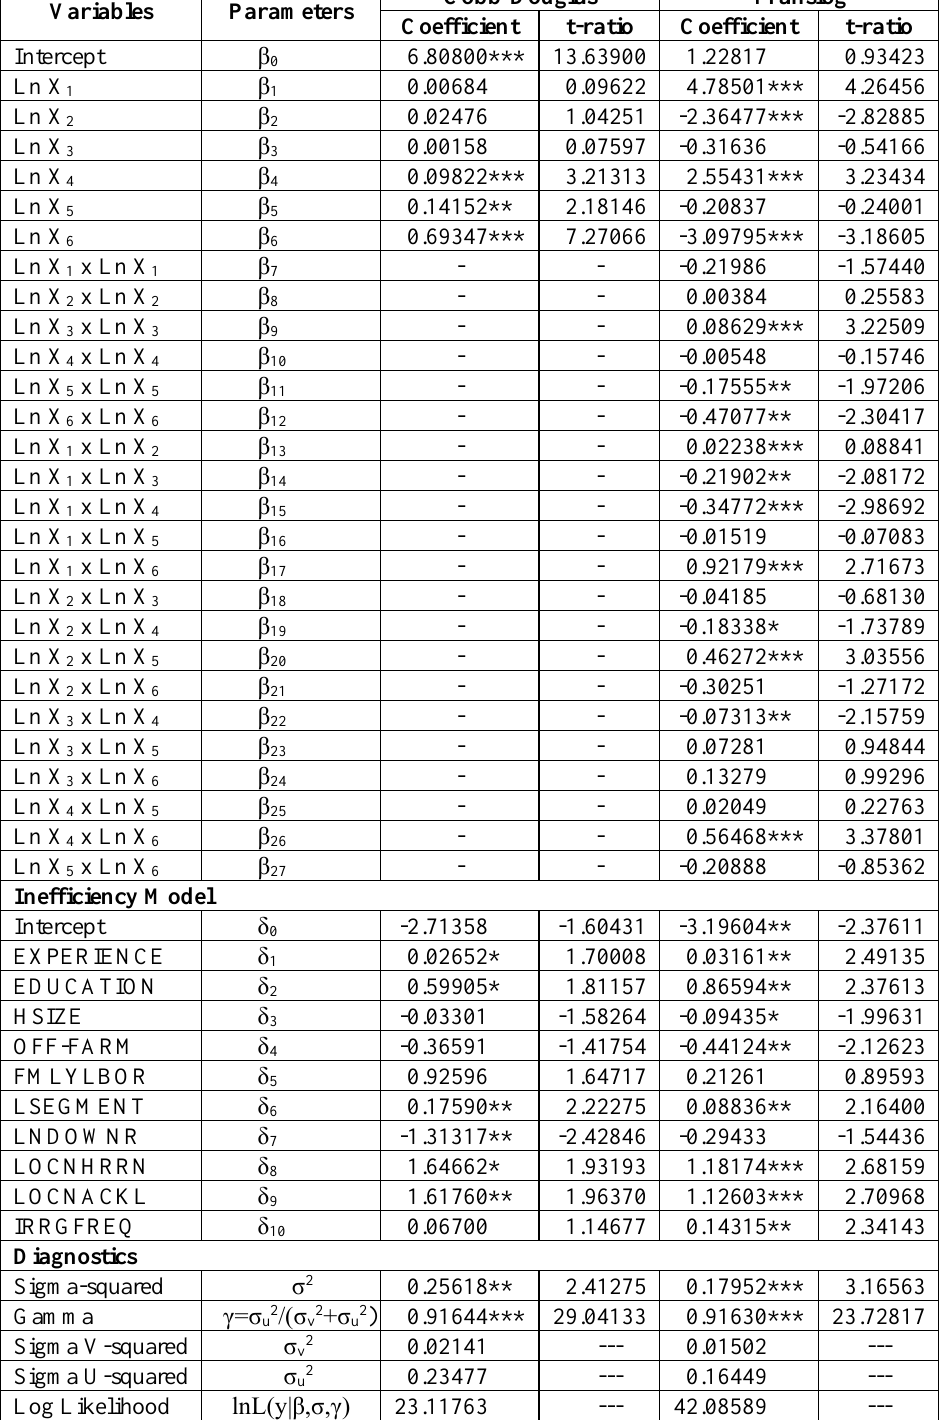
Table 5: Estimates of the stochastic frontier models using the maximum likelihood technique. Cobb-Douglas Translog Variables Parameters Coefficient t-ratio Coefficient Intercept